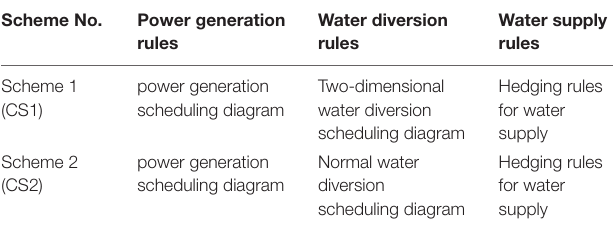
TABLE 2 | Dispatching rules set for comparison schemes. Scheme